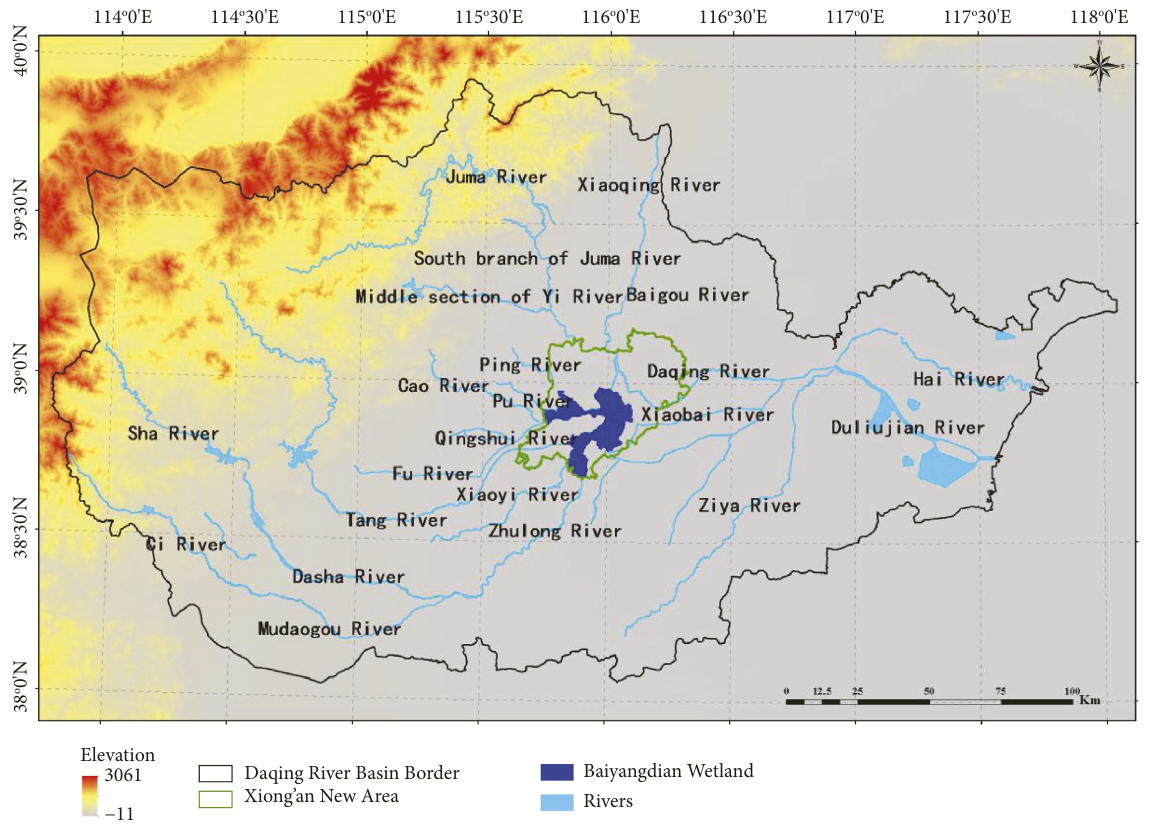
Figure 1: Overview of the study